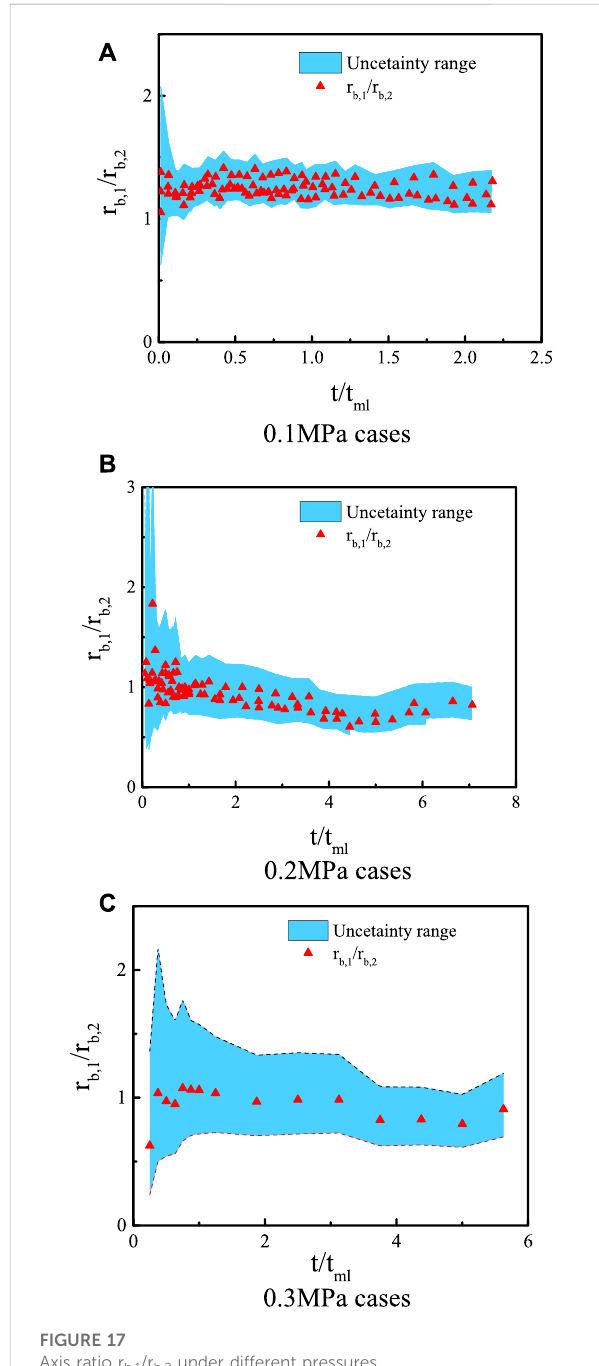
FIGURE 17 Axis ratio r b,1 /r b,2 under different